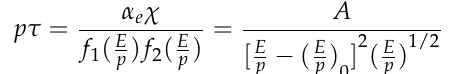
delay in ( a ) air and ( b ) SF 6